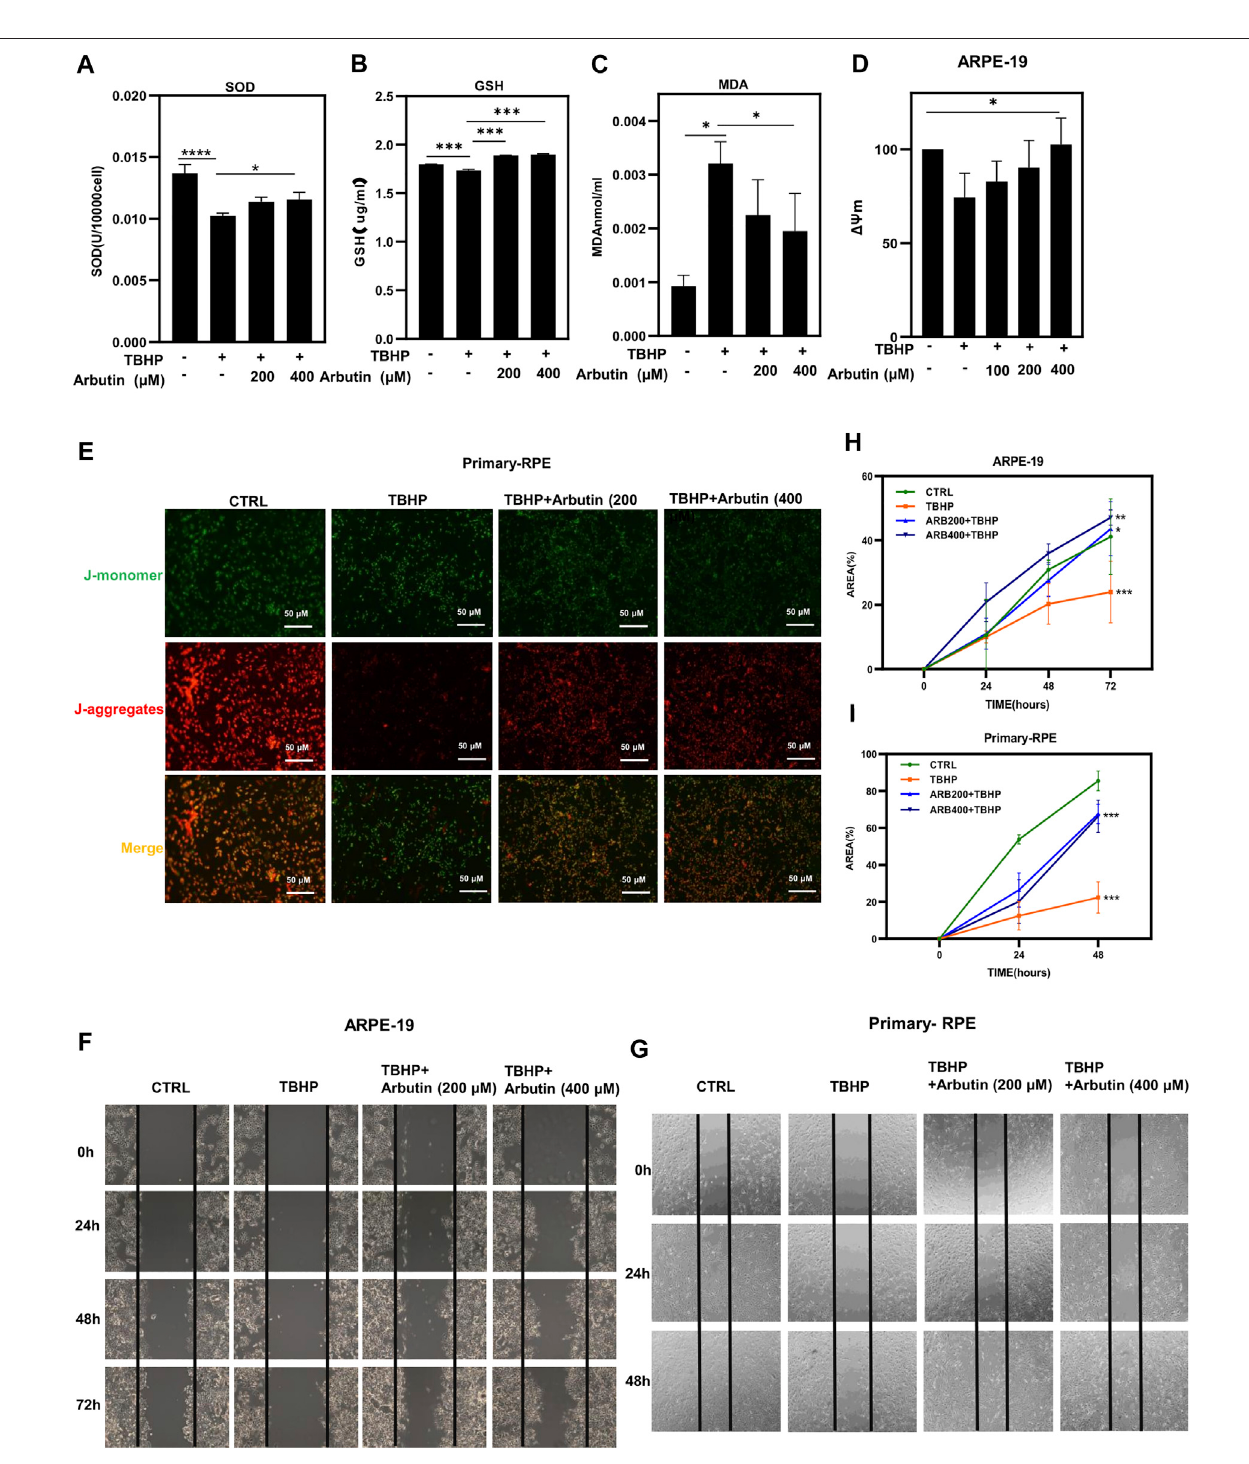
FIGURE 3 | Arbutin improved cellular functions of RPE cells under oxidative stress. (A) antioxidant enzyme level analysis of SOD in ARPE-19 cells during oxidative damage while with or without Arbutin pretreatment. (B) glutathione peroxidase activity was detected. (C) malondialdehyde (MDA) was measured in different ARPE-19 cell treatments. (D) the statistical histogram ofmitochondrial functionalexamination showed that 100mm, 200 μ Mand 400 μ M Arbutinpromoted the ΔΨ m ofARPE-19 cellsduringTBHPtreatment. (E) fl uorescenceimagescollectedafterJC1stainingshowthatArbutinrestoresJC-1aggregates/monomerratioinprimary-RPEcells. (F) ARPE-19 cells were seeded in a24-well plate and applied woundsat thecon fl uence of80%. The cellswerepretreatedwith or without Arbutin and then subjected to TBHP (350 µM). Photos were taken at different time points post distinct treatments. (G) human primary-RPE cells planted in a 24-well plate and created wounds at the density of 80%. The cells were pretreated with or without Arbutin and then subjected to TBHP (350 µM). (H) the area of ARPE-19 cells situated amid the two black lines was calculated from images. (I) the area of human primary-RPE cells situated amid the two black lines was calculated from images. (* p < 0.05, ** p < 0.01, *** p < 0.001, n = 3, bars represent